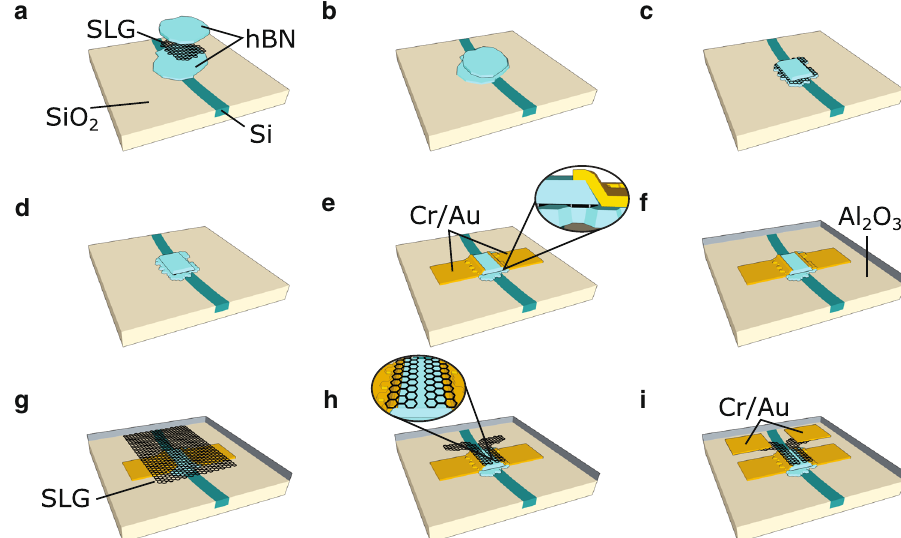
Fig. 2 Device fabrication. a Assembly of hBN/SLG/hBN. b Stack placement on photonic circuit and interface cleaning. c hBN etching in SF 6 plasma. d SLG etching in O 2 plasma to de fi ne channel geometry. e Metallization (Cr/Au) for drain-source contacts. f Al seed layer evaporation and ALD of Al 2 O 3 . g Wet transfer of CVD SLG. h Split-gate fabrication. i Metallization (Cr/Au) for gate Fig. 2 and described in Methods. A microscope image of hBN/